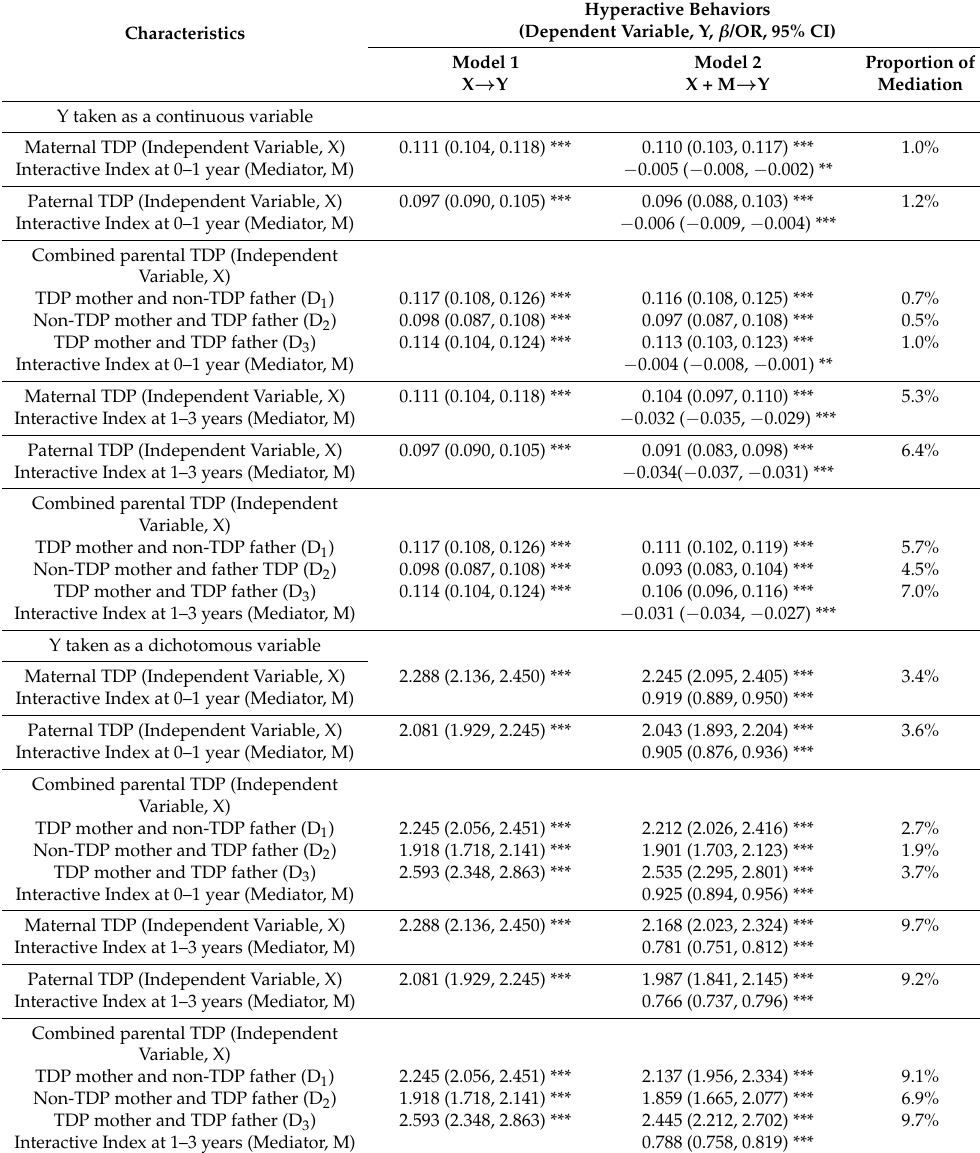
Table 3. Mediation effect of parent–child interactive activities on the associations between parental TDP and children’s hyperactive